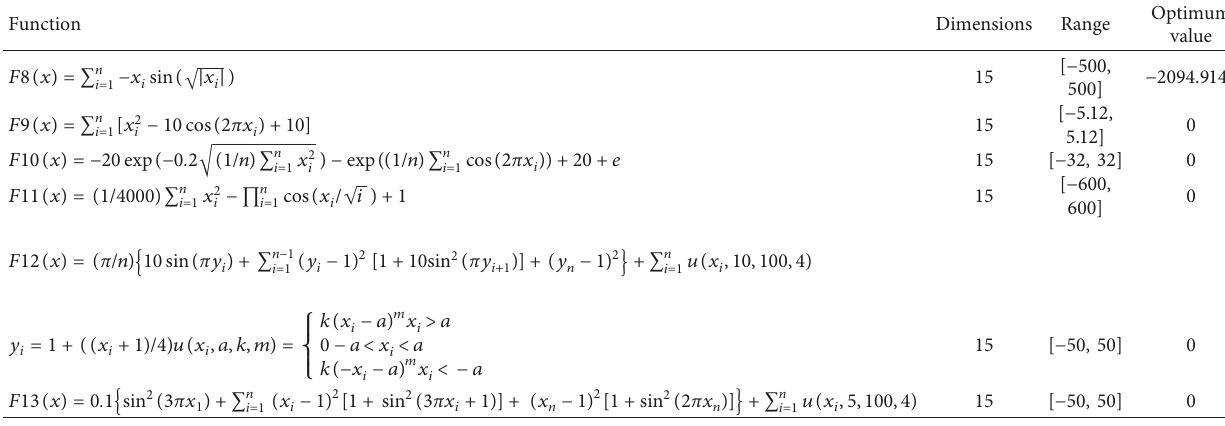
Table 2: Multimodal benchmark